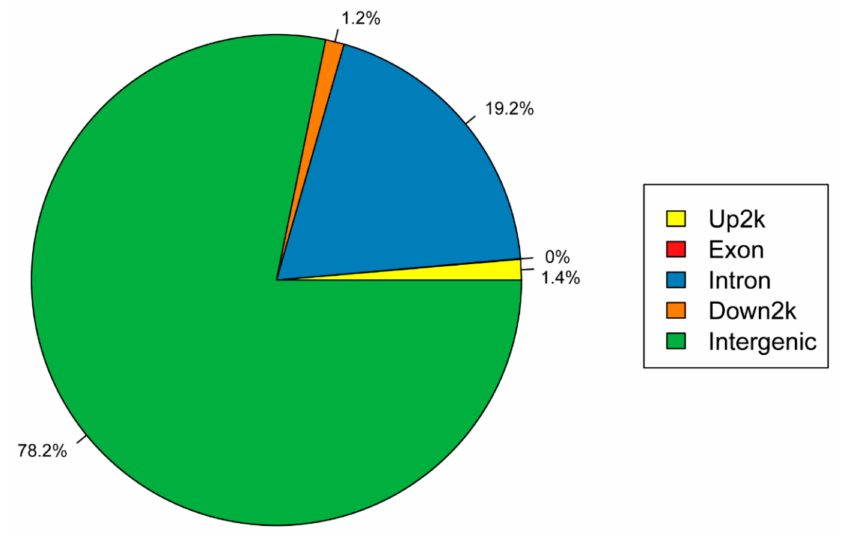
Figure 1. Locations of simple sequence repeats in the giant panda genome.